Question: Based on the figure, does the quantity rise or fall?
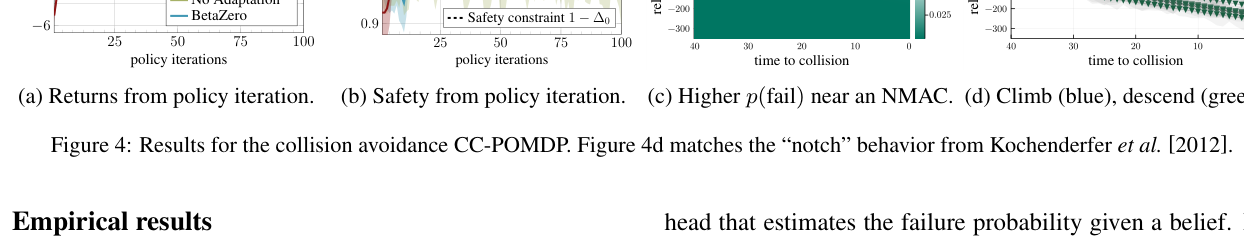
Answer: increasing